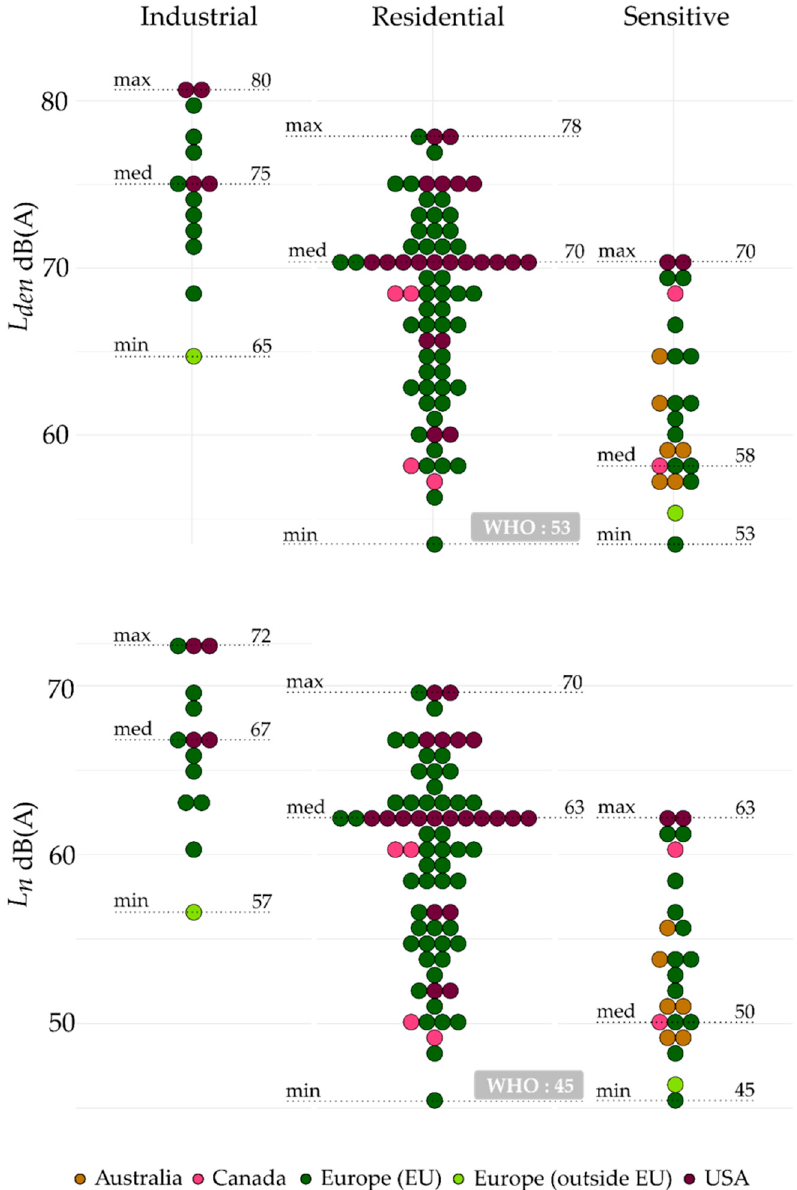
Figure 8. Outdoor noise limits converted to L den (upper plot) and L n (lower plot) by Brink’s method and grouped by zone (industrial, residential, and sensitive). “WHO” indicates the limit recommended by the World Health